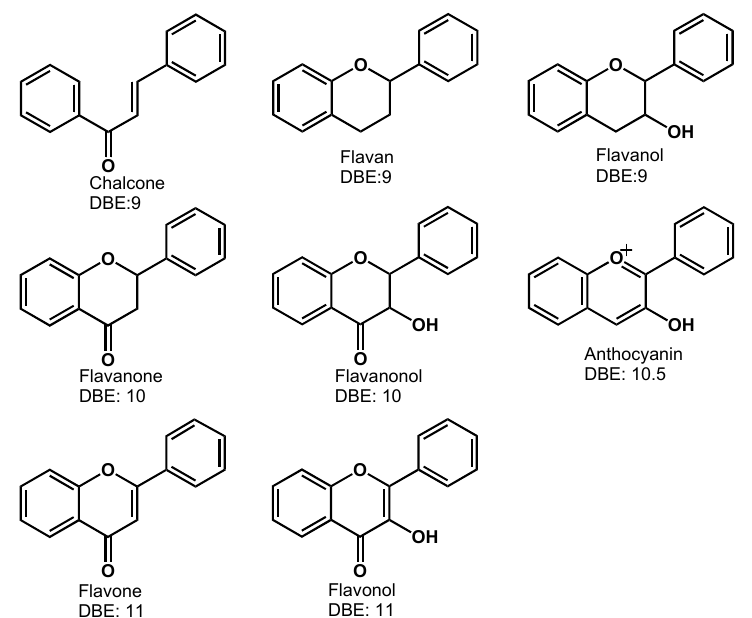
Scheme 1. The structures of main flavonoid groups and their double bond equivalent (DBE) val- ues.